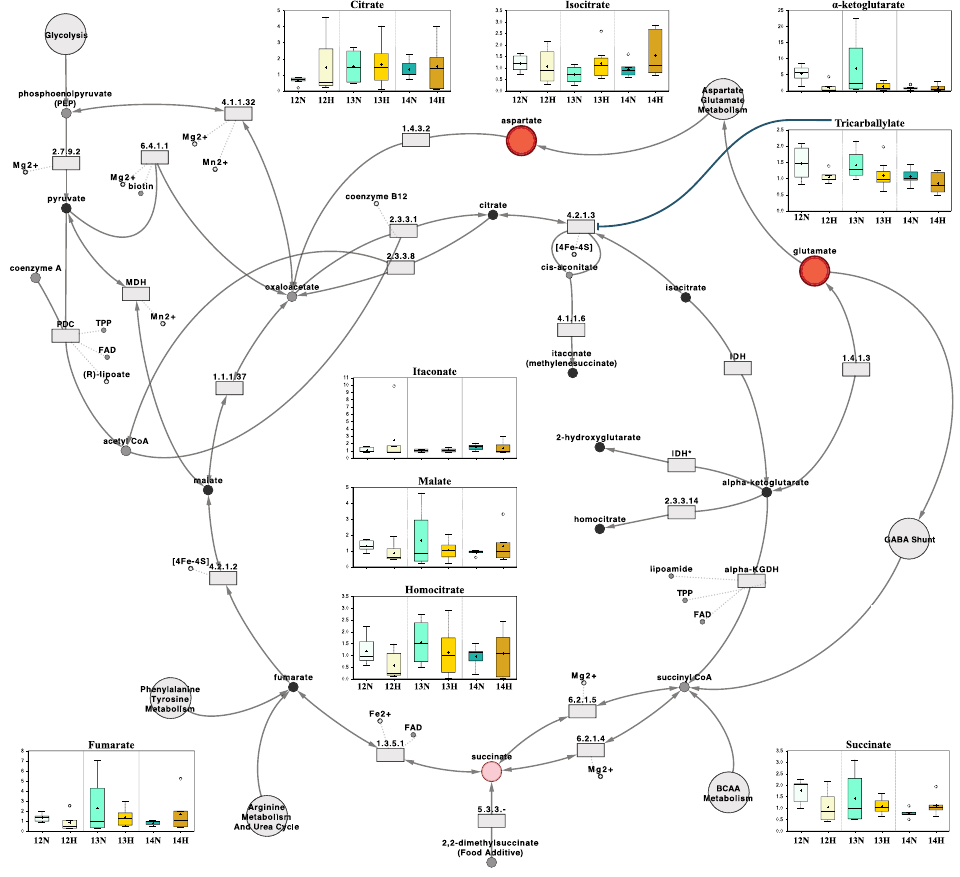
Figure 7. Tricarboxylic acid (Krebs) cycle metabolism, surrounded by the scaled intensities of relevant biochemicals. Biochemical node colour corresponds to day by progesterone (P4) interaction – dark red indicates a significant (p ≤ 0.05) interaction (node border thickness is inversely proportional to the magnitude of the p-value). Within these statistically significant nodes, node diameter is correlated to metabolic hierarchy (cofactor and intermediate metabolite nodes are smallest, followed by by-products, and central metabolites). Light red depicts an increasing trend (0.05 < p < 0.10), black depicts an identified amino acid which did not exhibit a day by progesterone interaction, and grey represents a biochemical present in the metabolic library but not detected in this study. Box plots: the central horizontal line represents the median value with outer boundaries depicting the upper and lower quartile limits. Error bars depict the minimum and maximum distributions, with + representing the mean value and ○ the extreme data point. Abbreviations: Day 12 Normal P4 (12N), Day 12 High P4 (12H), Day 13 Normal P4 (13N), Day 13 High P4 (13H), Day 14 Normal P4 (14N), Day 14 High P4